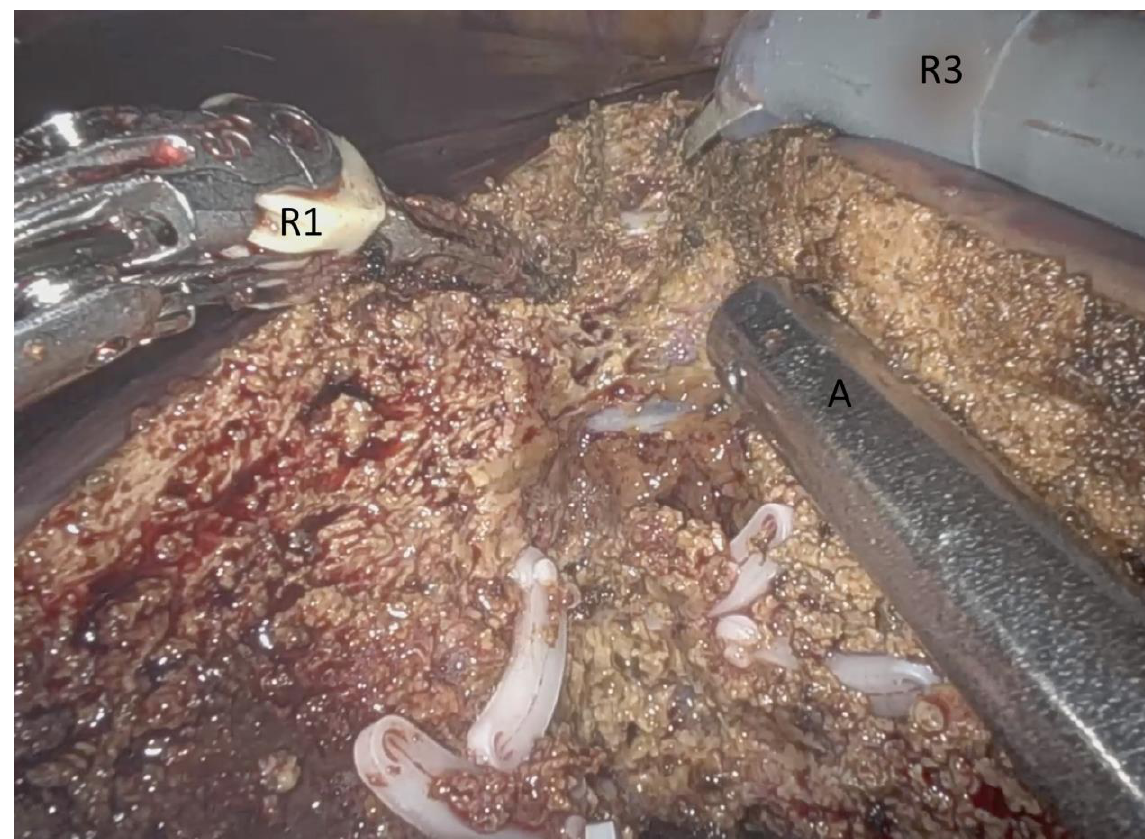
Figure 3. Intraoperative view from the console during robotic-assisted liver resection, using the three device (3D) technique for liver parenchyma dissection (DaVinci Xi System, Intuitive Surgical, Inc., Sunnyvale, CA, USA). R1: Robotic arm 1 with bipolar Maryland forceps, R3: Robotic arm 3 with monopolar scissors, A: Waterjet (Erbejet ® 2, Erbe Elektromedizin GmbH, Tuebingen, Germany) driven as laparoscopic instrument via the assistant at the table (Video S1).